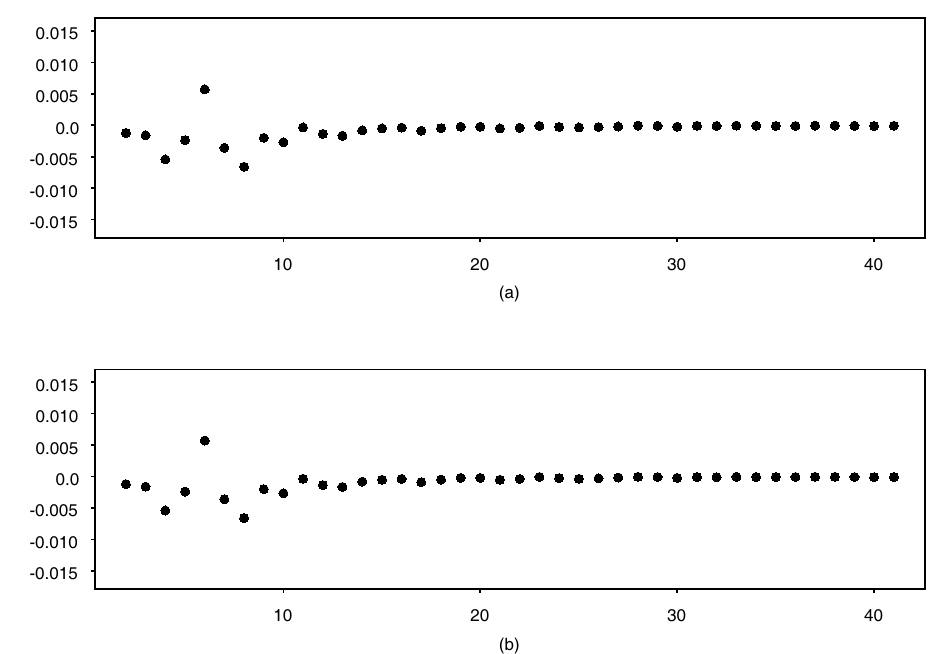
Figure 1 – Difference between the sample ratio of means (x) g and its basic linear approximation given by (4) (panel (a)), and difference between (x) g and its higher-order sample linear approxima- tion given by (5) (panel (b)), for 40 different sample sizes n (horizontal axes) ranging from 2 n (cid:32) to 41 n (cid:32)